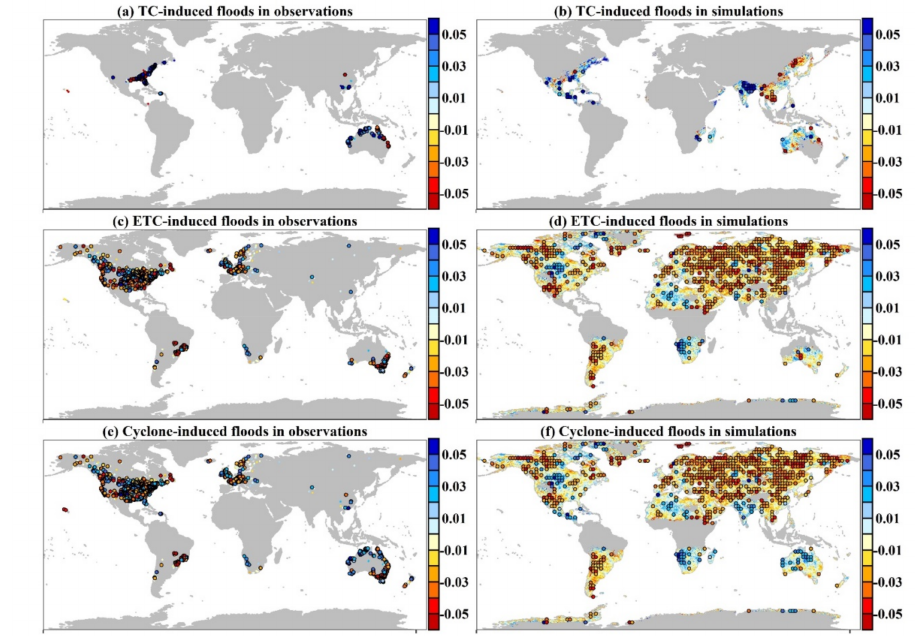
Figure 8. Long-term changes in the frequency of TC, ETC, and cyclone-induced floods in observations ( a , c , e ) and simulations ( b , d , f ) during 1979–2012. The trend is quantified by the Poisson regression, and the colored points (grids) based on observations (simulations) represent slope coefficient β 1 in Equation (3). A higher probability of BM floods induced by cyclones with increasing (decreasing) frequency are detected when β 1 is more (less) than zero. Moreover, the larger ring-shaped dots indicate the stations with significant change